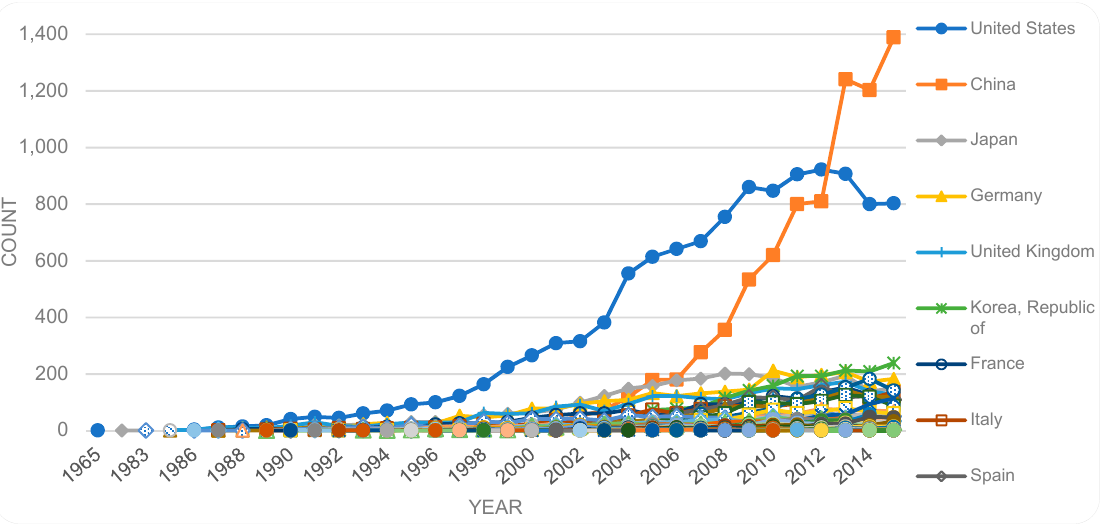
Figure 9. Countries in descending order of publication counts with more than total number of 500 by year (based on countries of the first authors).